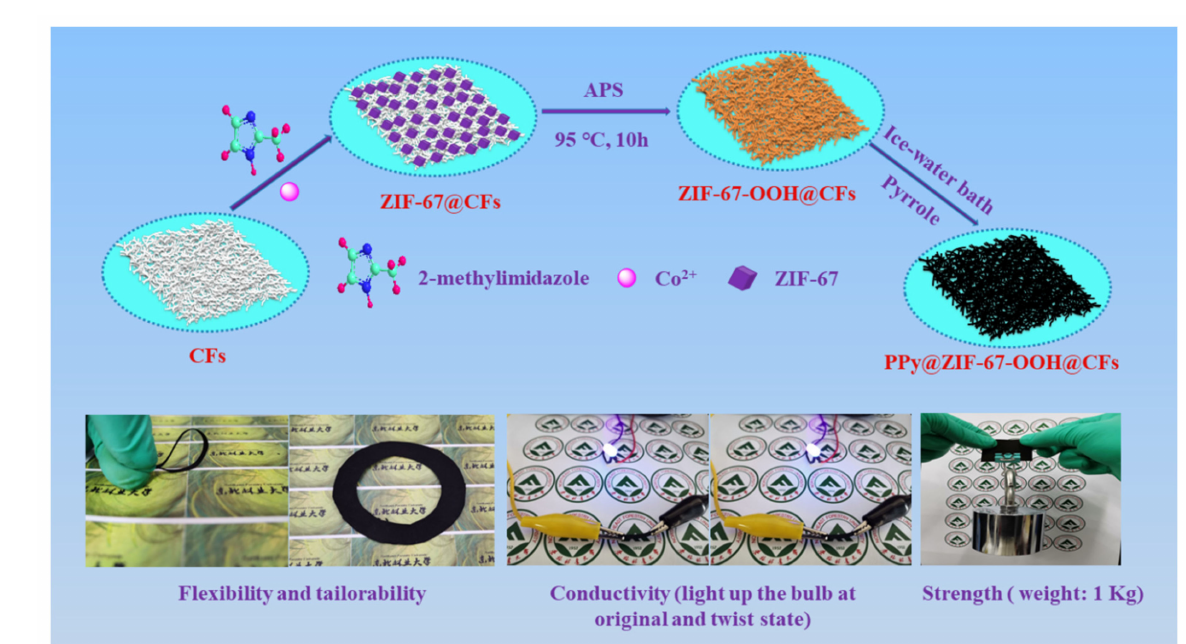
Figure 1. Fabrication process of PPy@ZIF-67 derived cobalt oxyhydroxide@CFs (PZCC) hybrid electrode materials and photographic images (flexibility, tailorability, conductivity, and